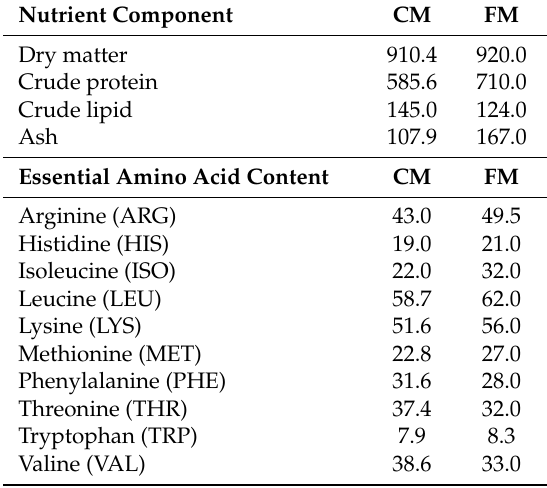
Table 1. Chemical composition (g/kg) and essential amino acid (g/kg dry matter) content of chironomid meal (CM) and fish meal (FM).